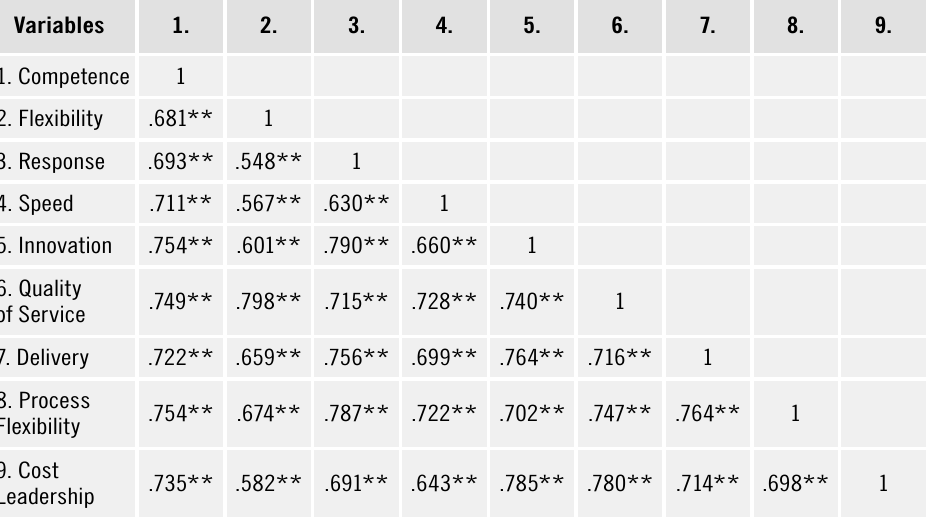
Table 5. Correlation analysis results: